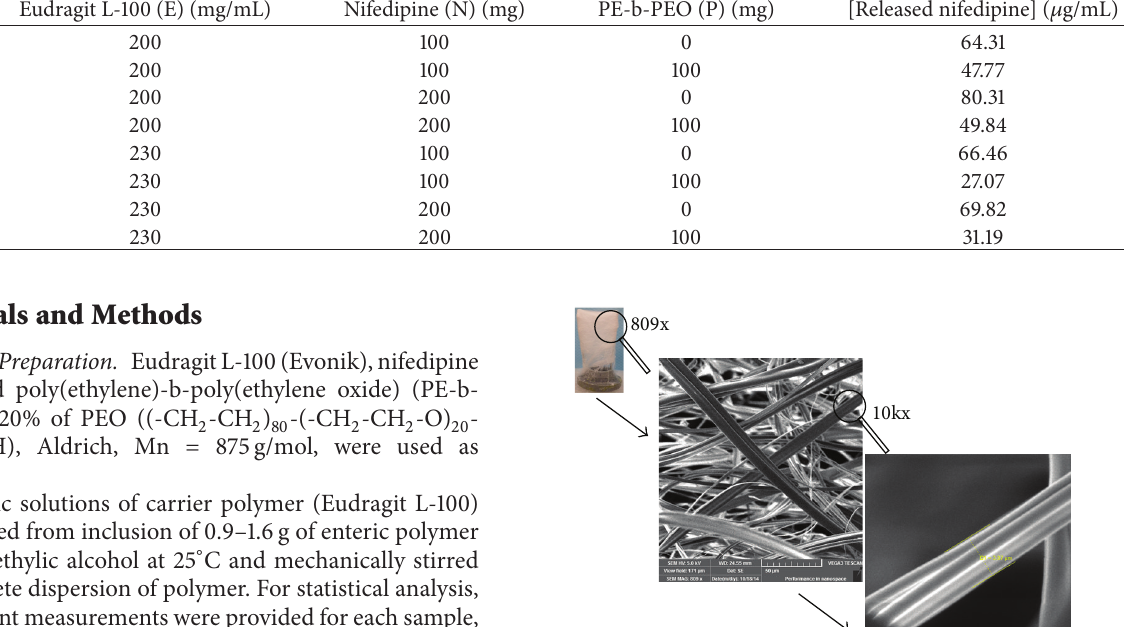
Table 1: Concentration of released nifedipine from electrospun fibers obtained at different combination of parameters (E, N, and P). Samples